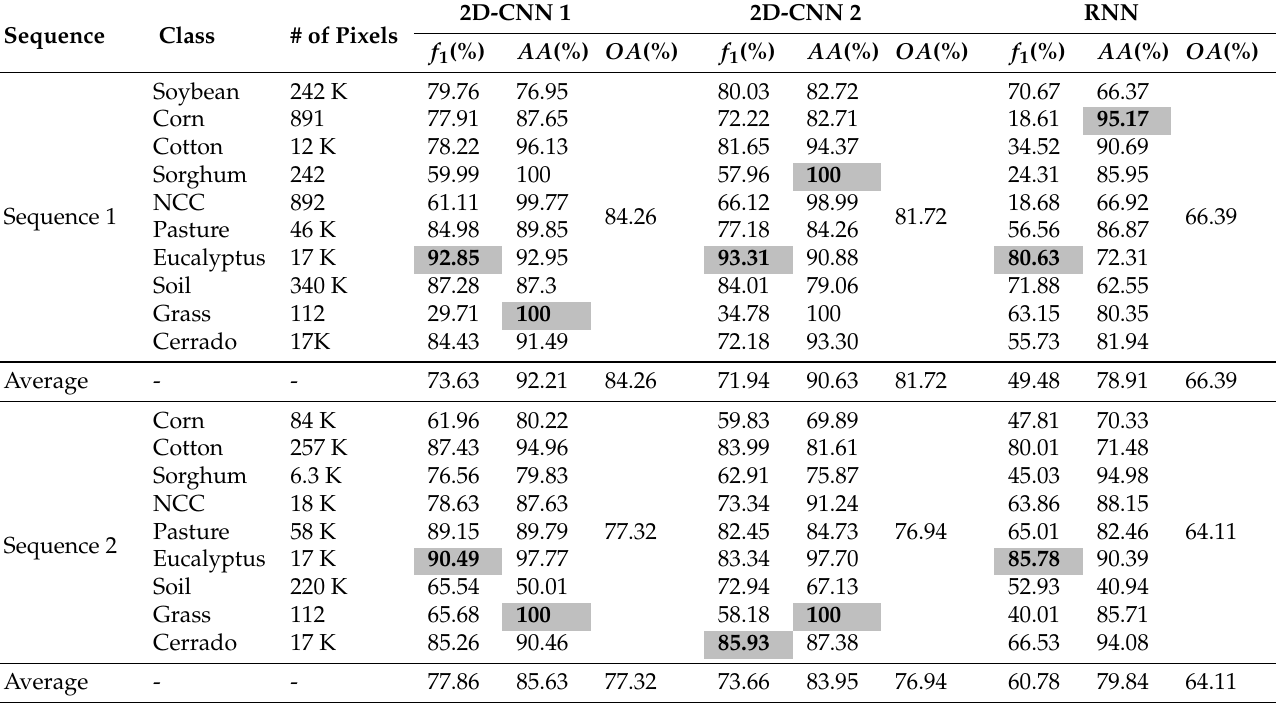
Table 4. The overall performance of the proposed DL architectures for patch classification tasks in terms of OA , AA , and f 1 metrics. The best measurements achieved by each architecture are highlighted and it is observed that the 2D-CNN 1 leads to higher OA values in both image sequences.